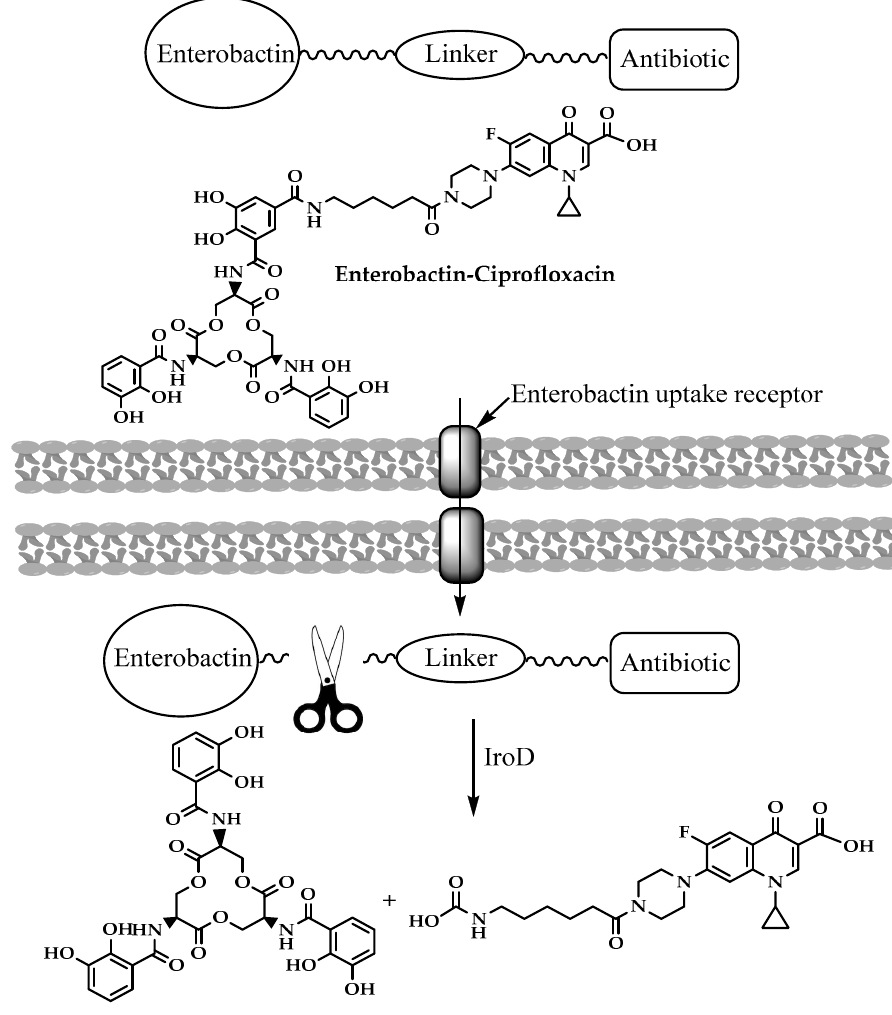
Figure 7. Enterobactin-ciprofloxacin conjugates activation.